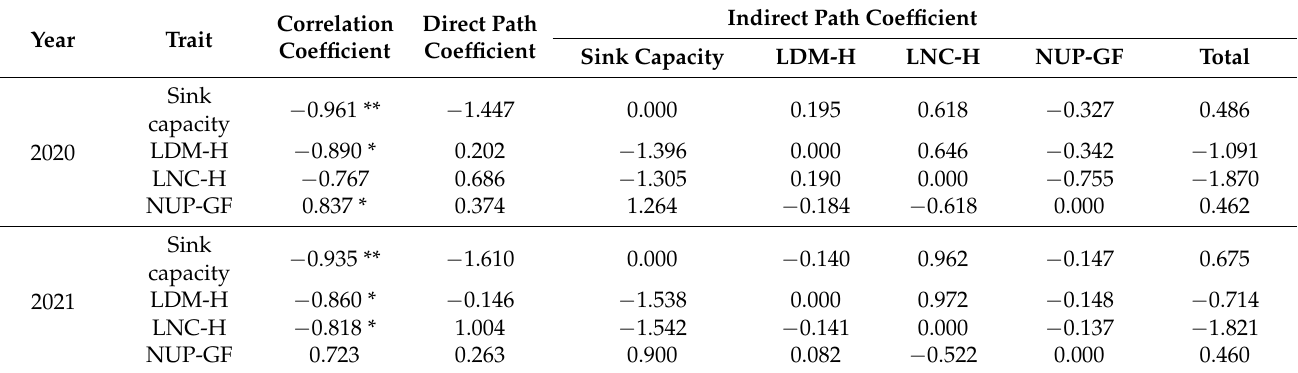
Table 8. Path analysis of NAV and its